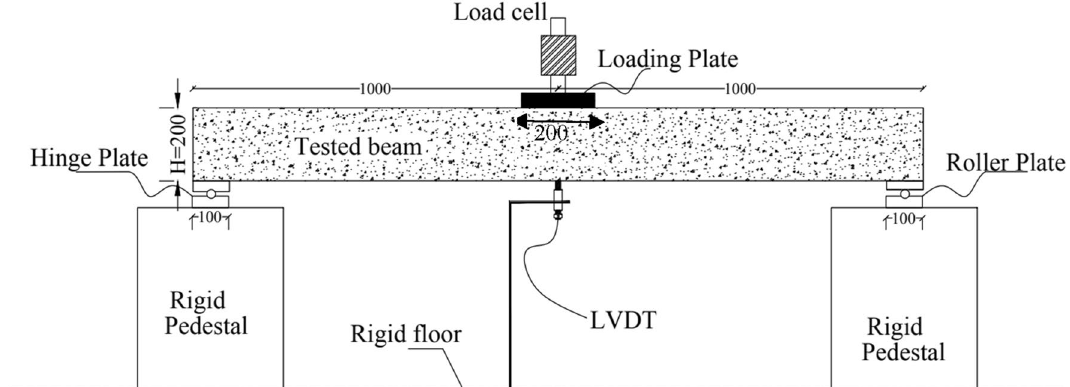
Fig. 12 Test setup and measurements, dim in